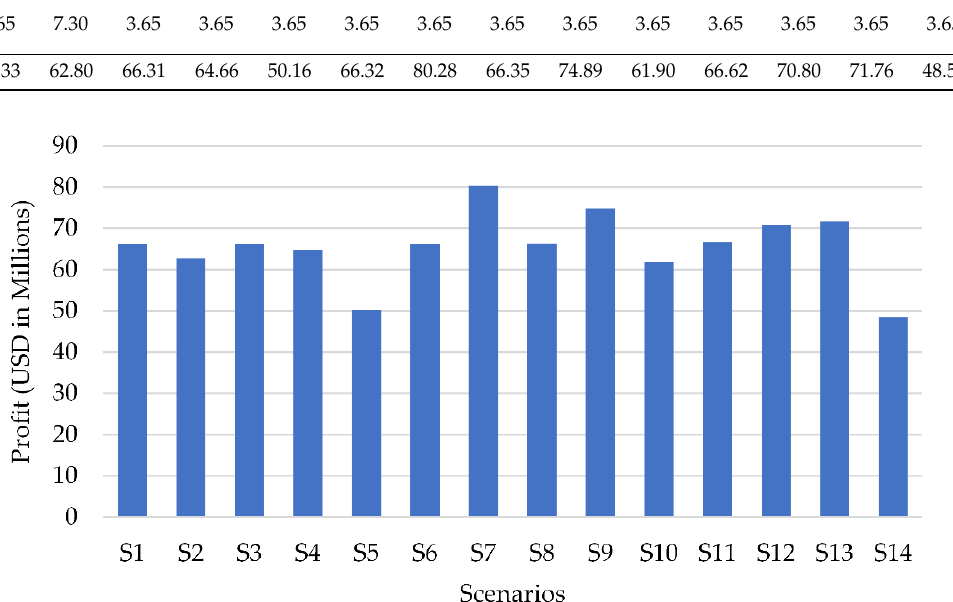
Figure 7. Overall expected profit for each simulated